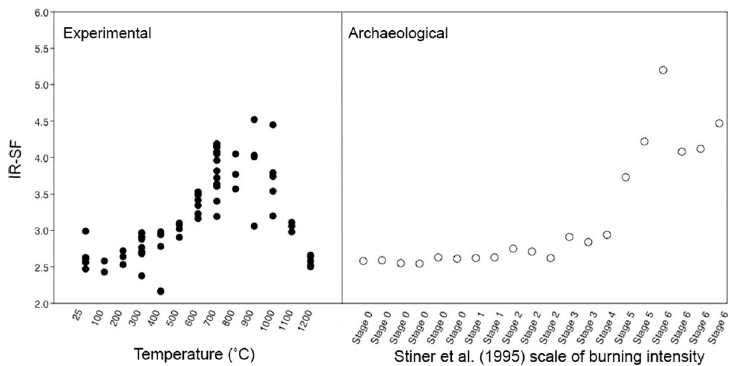
Fig 4. Infrared Splitting Factor (IRSF) of the experimental modern and archaeological collection measured from FTIR-ATR spectra following Weiner and Bar Yosef [81].